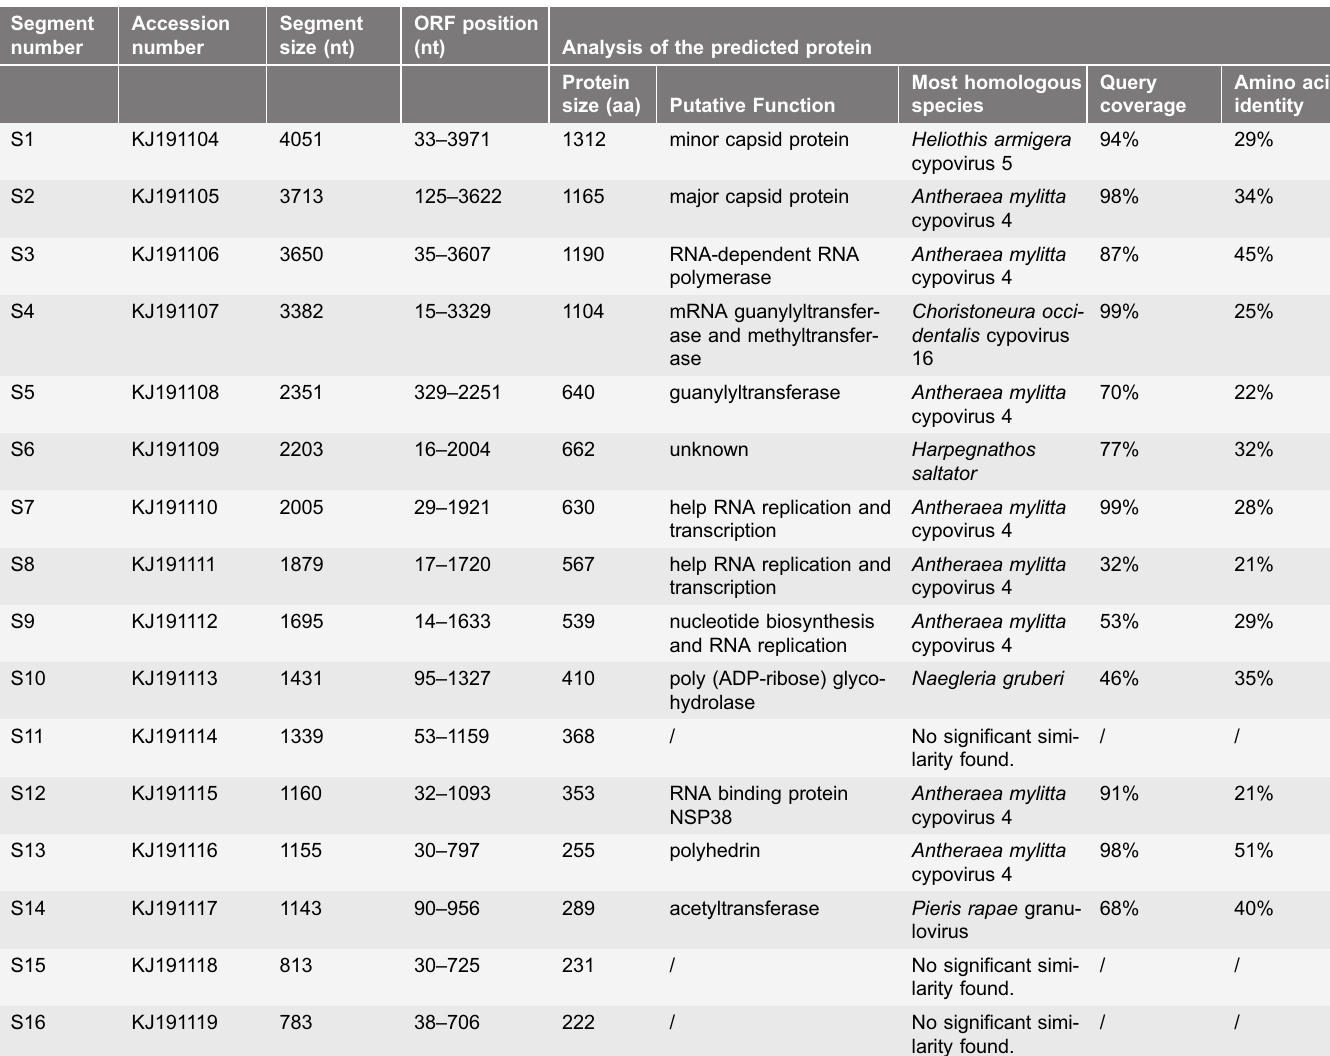
Table 3. Properties of the dsRNA segments of